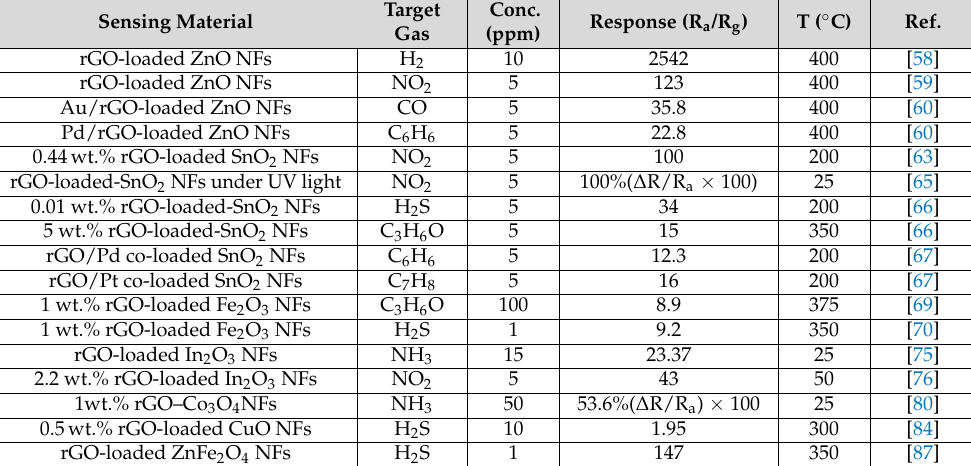
Table 1. Gas sensing characteristics of rGO-loaded metal oxide